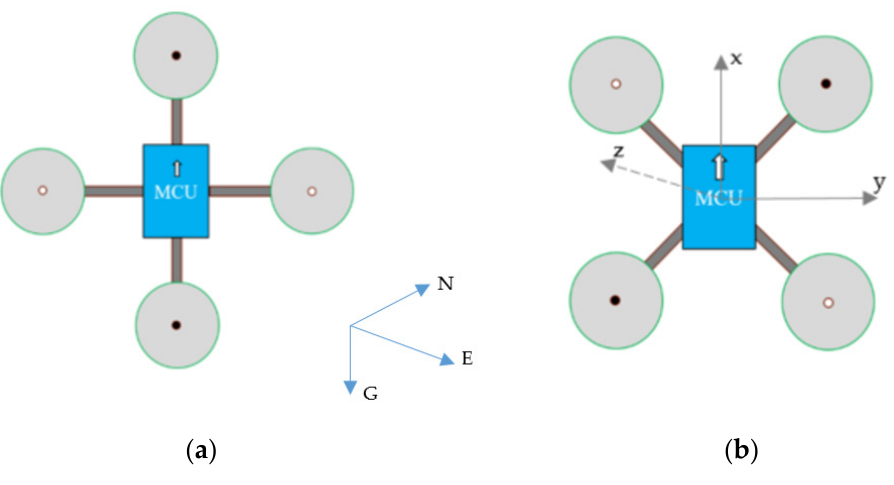
Figure 1. Two types of quadrotor layout. ( a ) Type “+”; ( b ) type “x”.